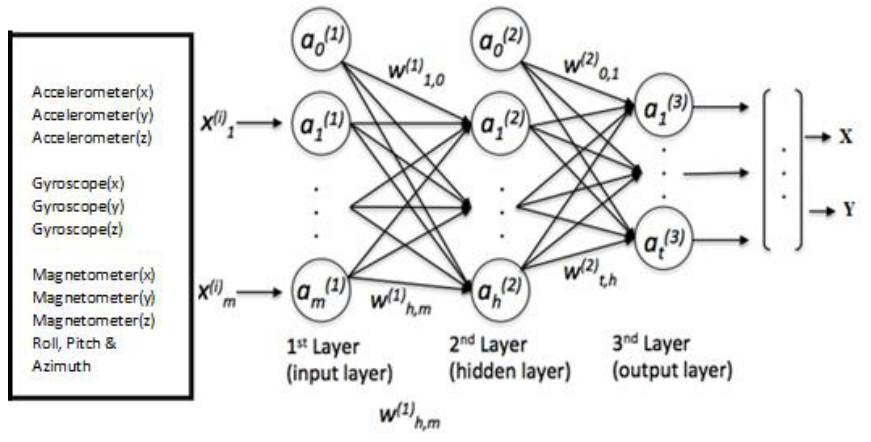
Figure 6. The MLPv1 network structure.